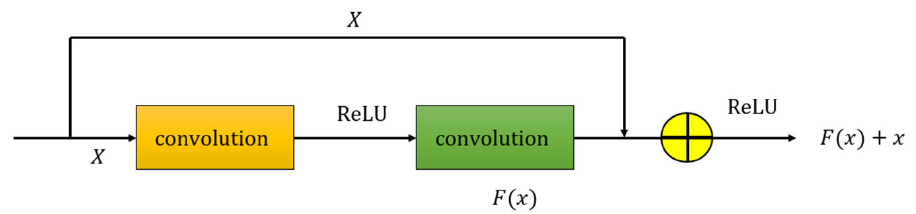
Figure 2. The residual